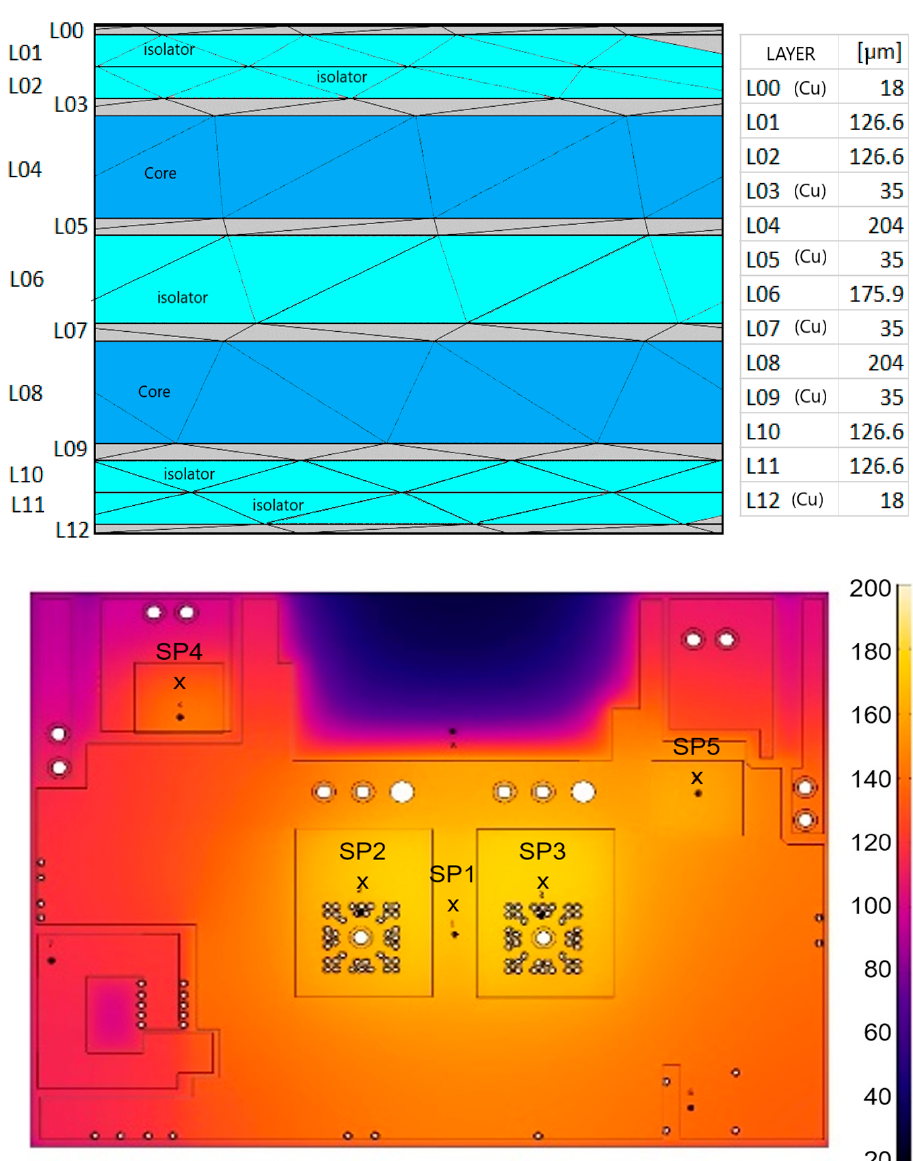
Figure 9. The developed model with grid distribution—the cross-section view of layers (L) and the thermal transient simulation for P out = 700 W (a top side view).